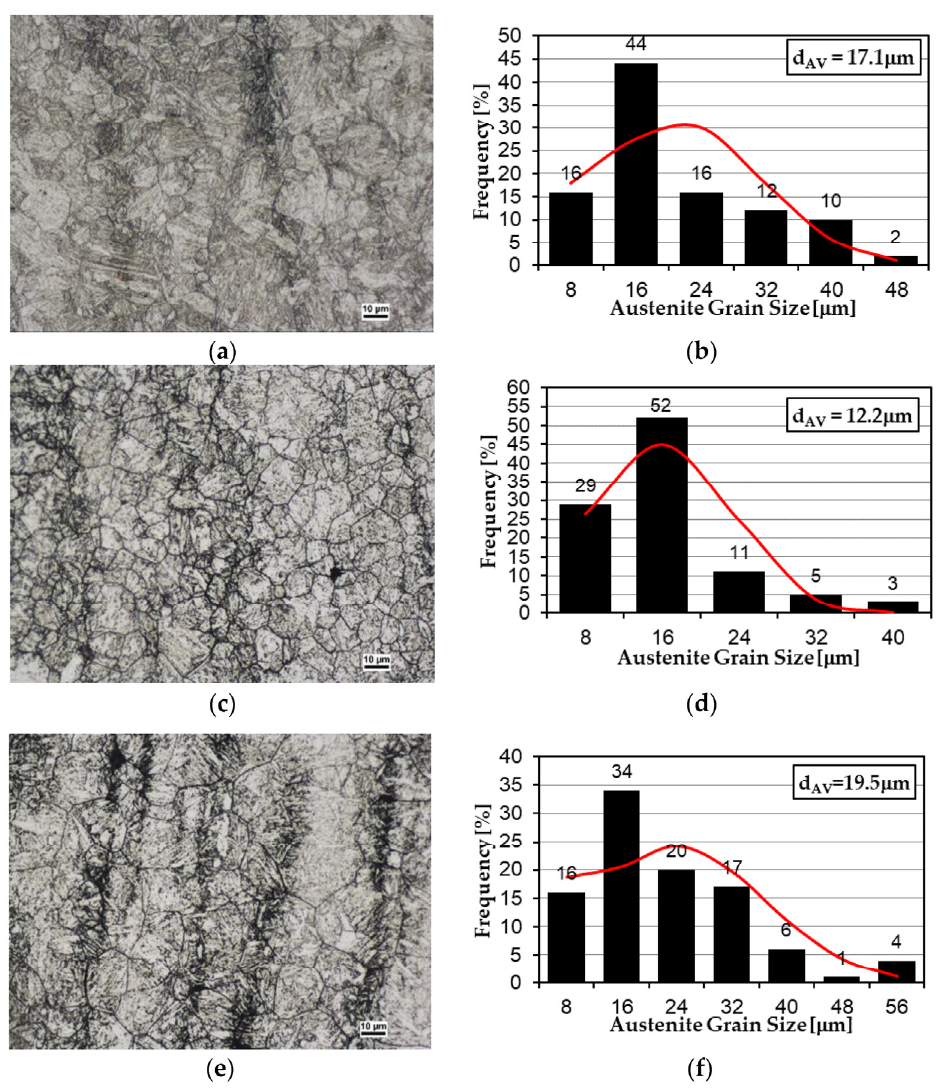
Figure 3. Microstructures of the analyzed abrasion-resistant steels with revealed former austenite grain boundaries. ( a , b ) Hardox 500, ( c , d ) Hardox 600, ( e , f ) Hardox Extreme. Light microscopy. Etched with Mi17Fe (Pikral).